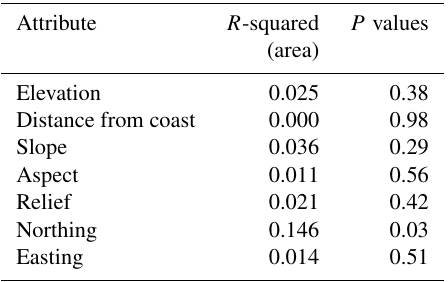
Table 1. The relationship between potential geographical and topo- graphical attributes with cumulative area